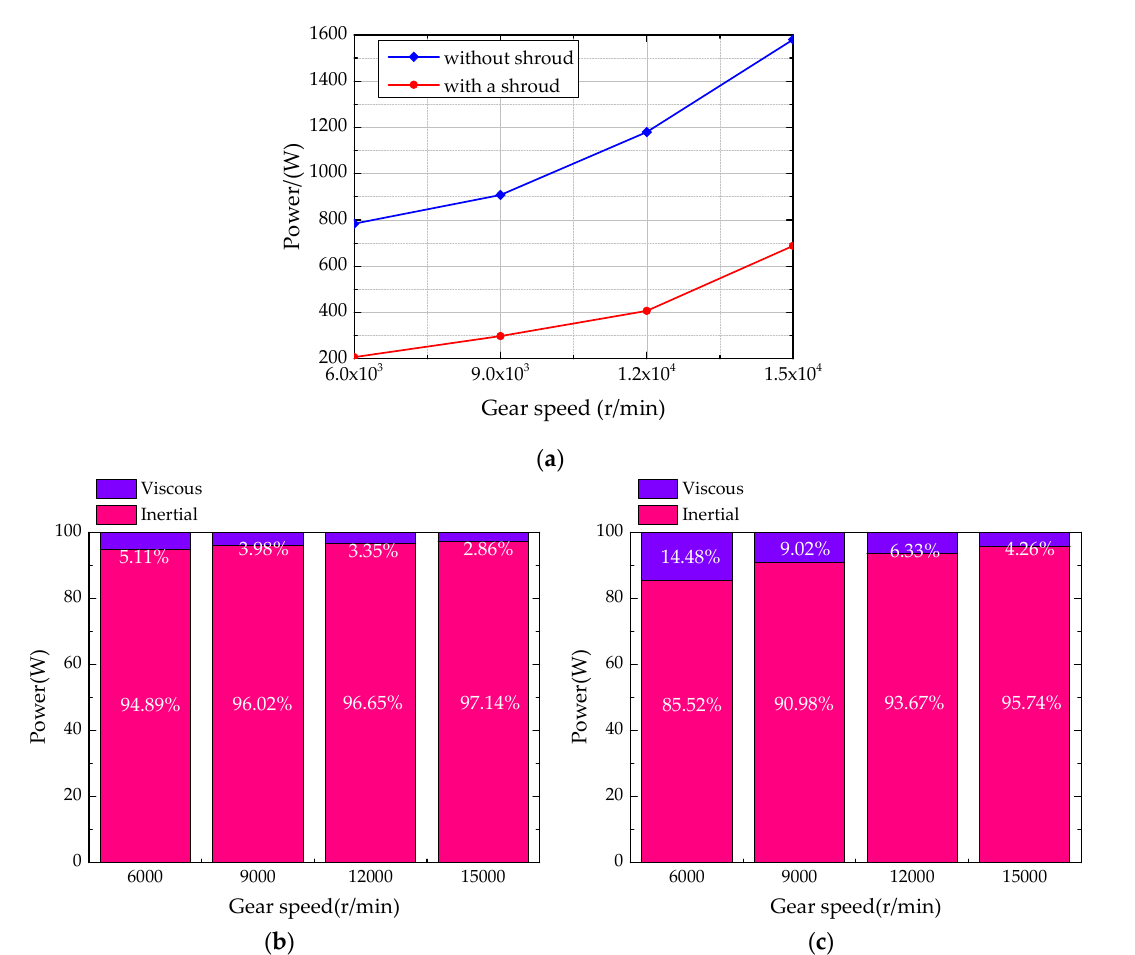
Figure 11. ( a ) The trend of the power losses without and with a shroud at different speeds: ( b ) the inertial and viscosity contributions to the total power losses without a shroud; ( c ) the inertial and viscosity contributions to the total power losses with a shroud.